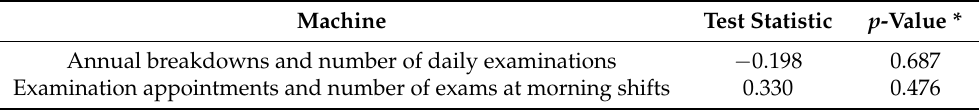
Table 5. The relationship between annual breakdowns in CT and number of daily examinations and between examination appointments and number of exams at morning shifts. Machine Test Statistic p -Value * Annual breakdowns and number of daily examinations − 0.198 0.687 0.330